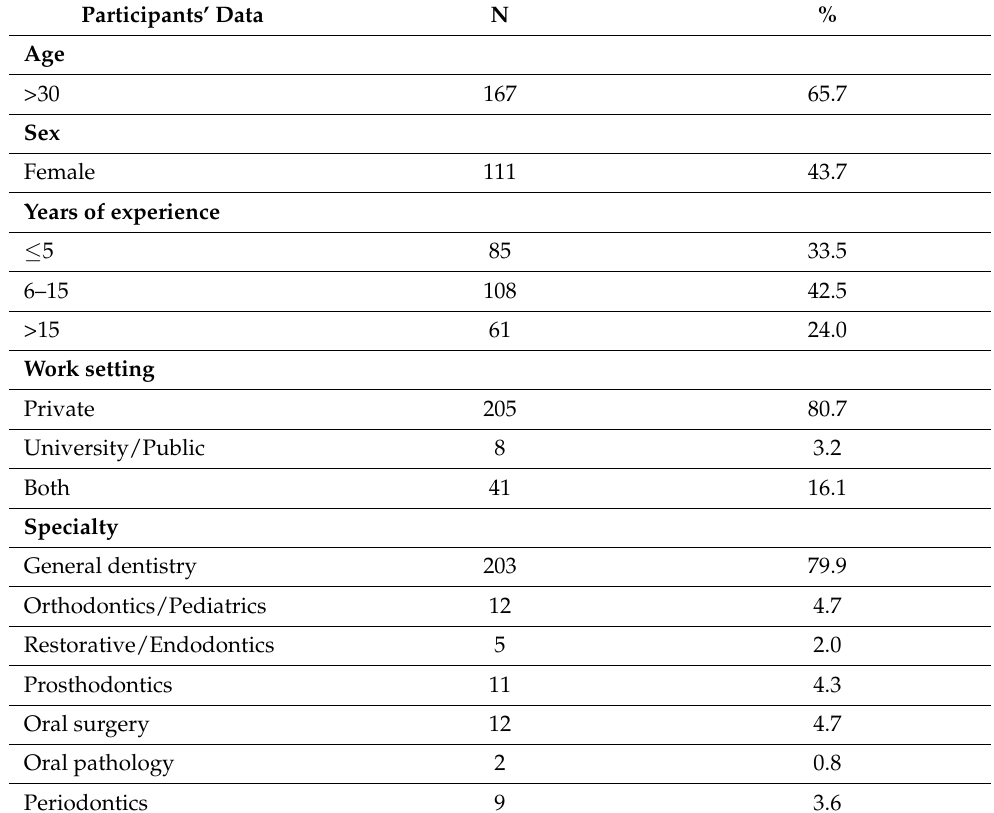
Table 1. Demographic and professional data ( n =